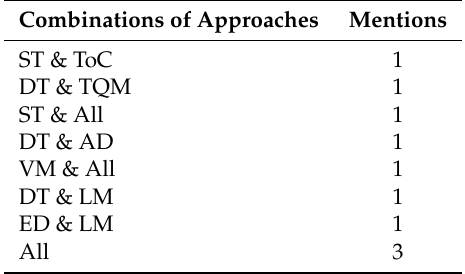
Table 9. Combinations of approaches cited by respondents.